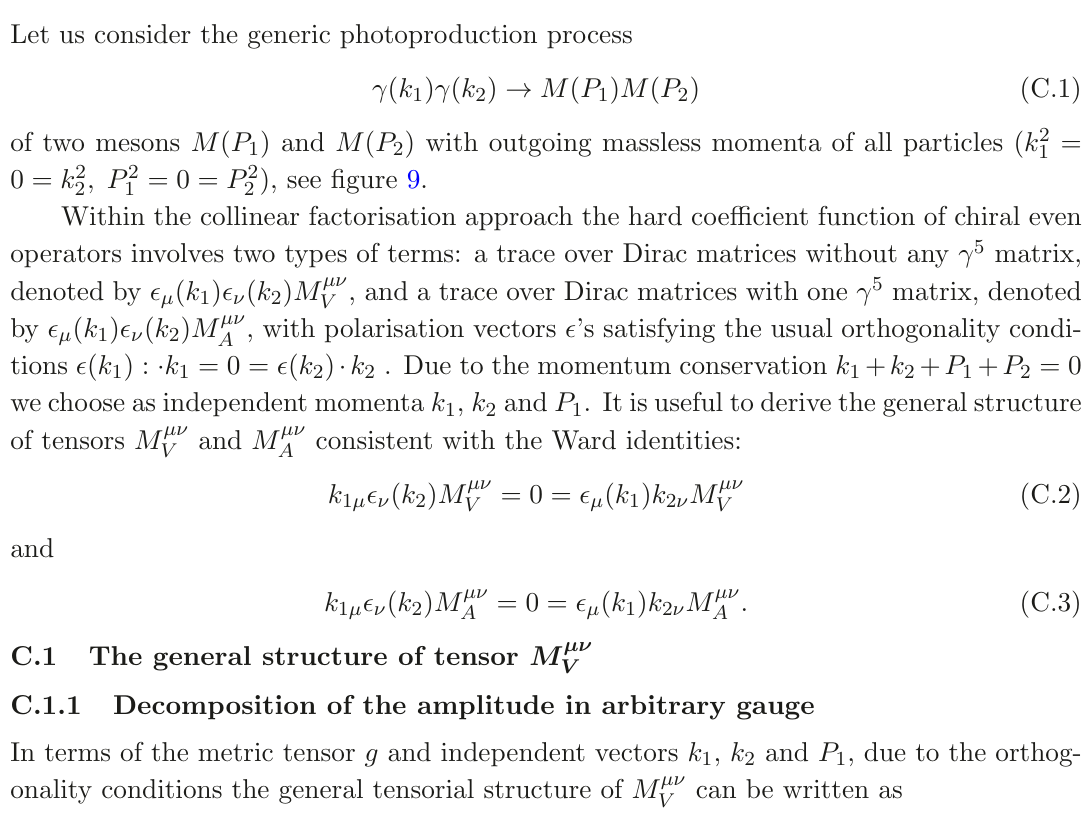
M ( P 1 ) M ( P 2 ) meson →